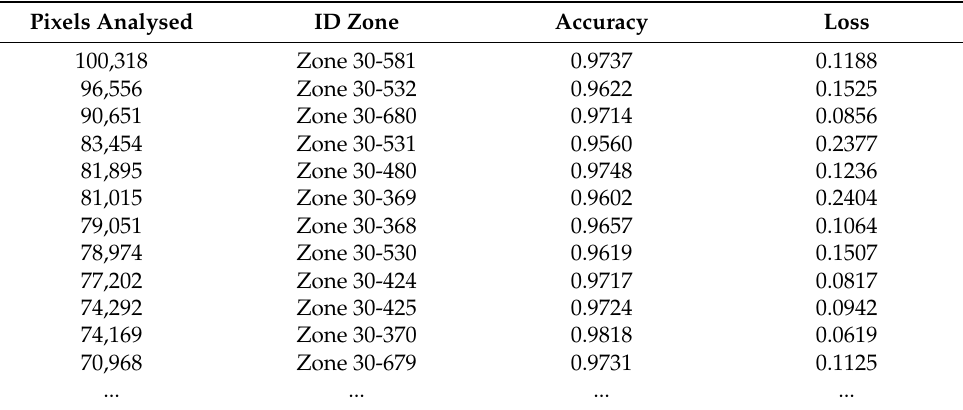
Figure 11. Comparative report of the two model architectures. ( a ) Classic CNN report; ( b ) Proposed model report. Table 3. Results of the first 12 zones ordered by the highest number of pixels in the studied area with the proposed model